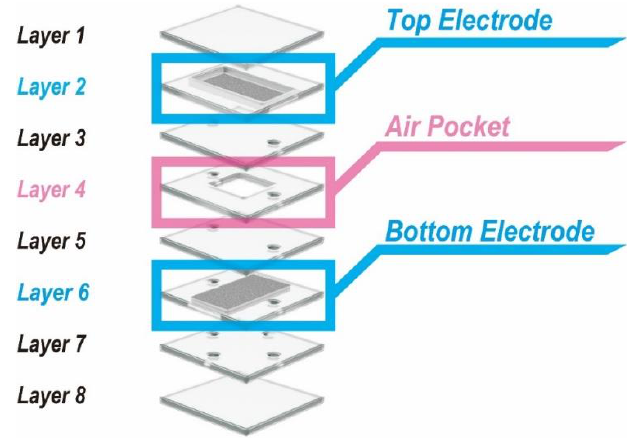
Figure 3. Structure of capacitive force sensor.